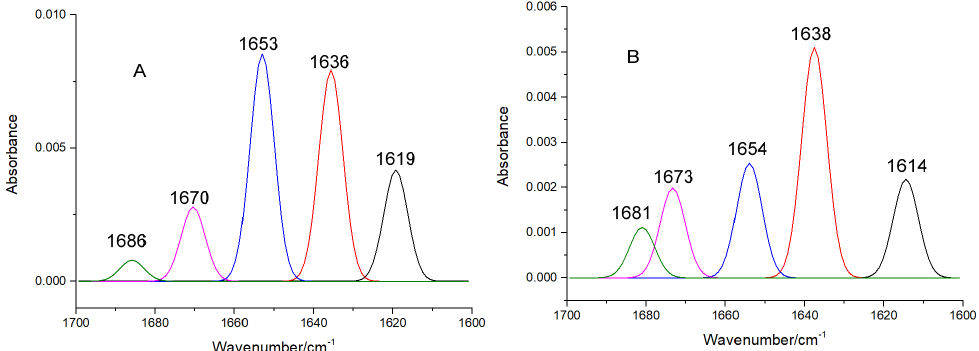
Figure 6. Extracted FT-IR spectra (1800 to 1400 cm − 1 ) of XO (red) and viniferifuran–XO solution (blue) at pH 7.0 and room temperature. The concentrations of XO and viniferifuran were 0.1 U/mL and 10 μ M, respectively.